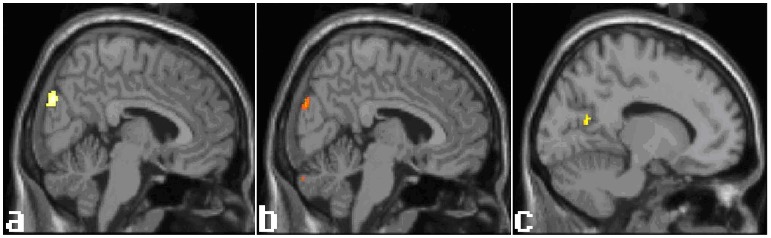
Activation of visual-related cortex by acupuncture.a: Activation in RA vs. SA. b: Activation in Group A vs. Group C. c: Activation in Group B vs. Group D. In both RA vs. SA and Group A vs. Group C, the activation occurred in the same right superior part of VII. The activation in Group B vs. Group D is in the interior part of the left VII. SPM maps the threshold at p<0.001, uncorrected for multiple comparison. See Table 2 for details. RA: real acupuncture (Group A with Group B). SA: sham acupuncture (Group C with Group D).